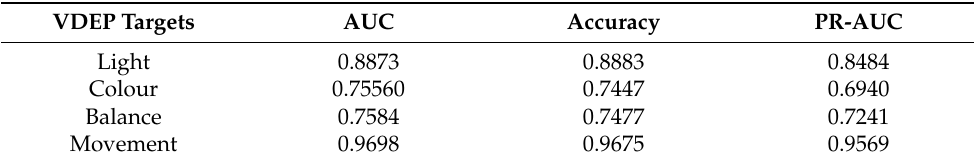
Table 2. Performance metrics of the CNN classification model for each of the target